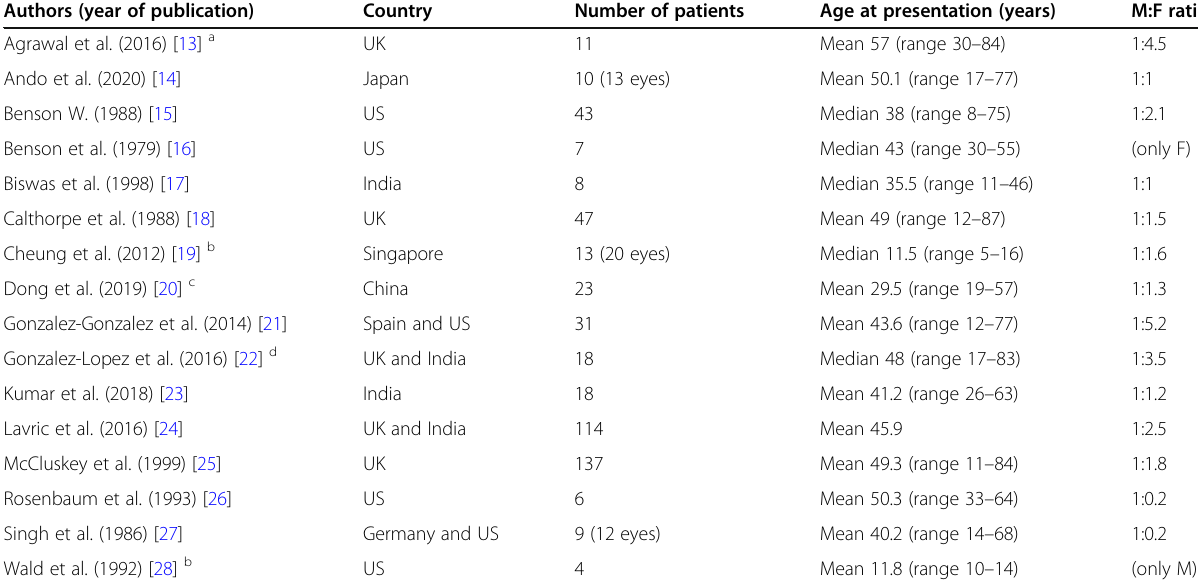
Table 1 Literature review of case series on posterior scleritis Authors (year of publication) Country Number of